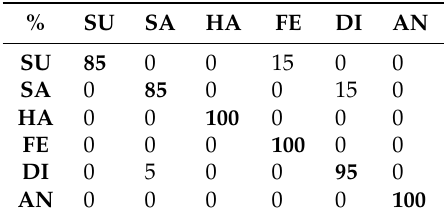
Table 15. Confusion matrix: 47 features employed UIBVFED database.